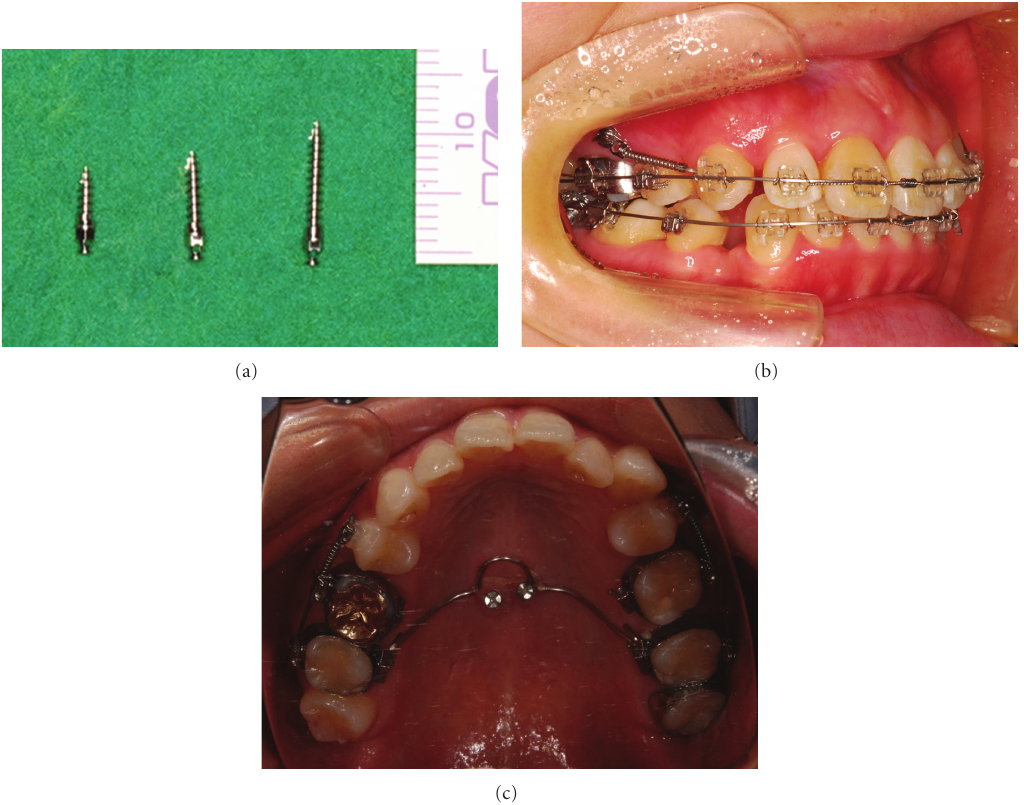
Figure 1: (a) Miniscrews, (b) the maxillary right canine was retracted with a closed coil from miniscrew, and (c) palatal implants. The maxillary 2nd molars were connected with trance palatal arch and palatal implants.